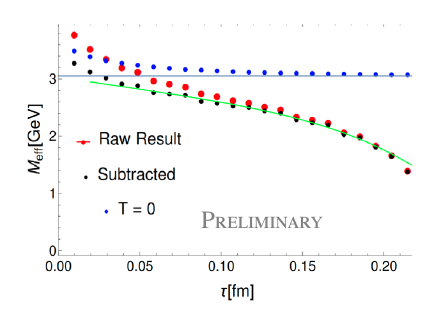
Figure 4. The e ff ective mass M e ff of the Wil- son line correlator at spatial distance r / a = 12 at high T = 839MeV (red circles) and at low T = 210MeV (blue circles). The e ff ective mass based on the UV subtracted T > T C cor- relator is shown as black